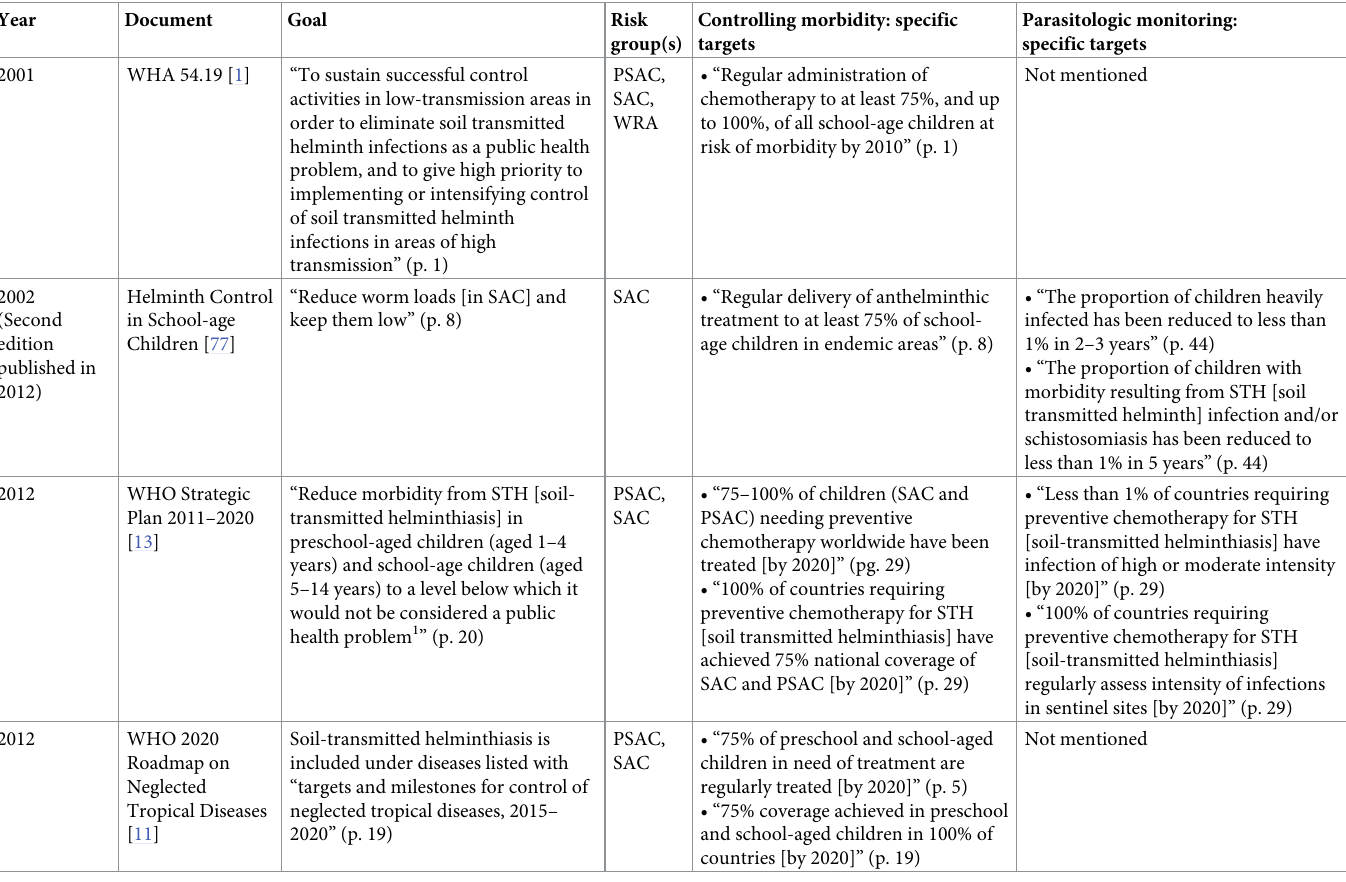
Table 1. Overview of the evolution of documents published by WHO pertaining to the control of soil-transmitted helminthiasis since